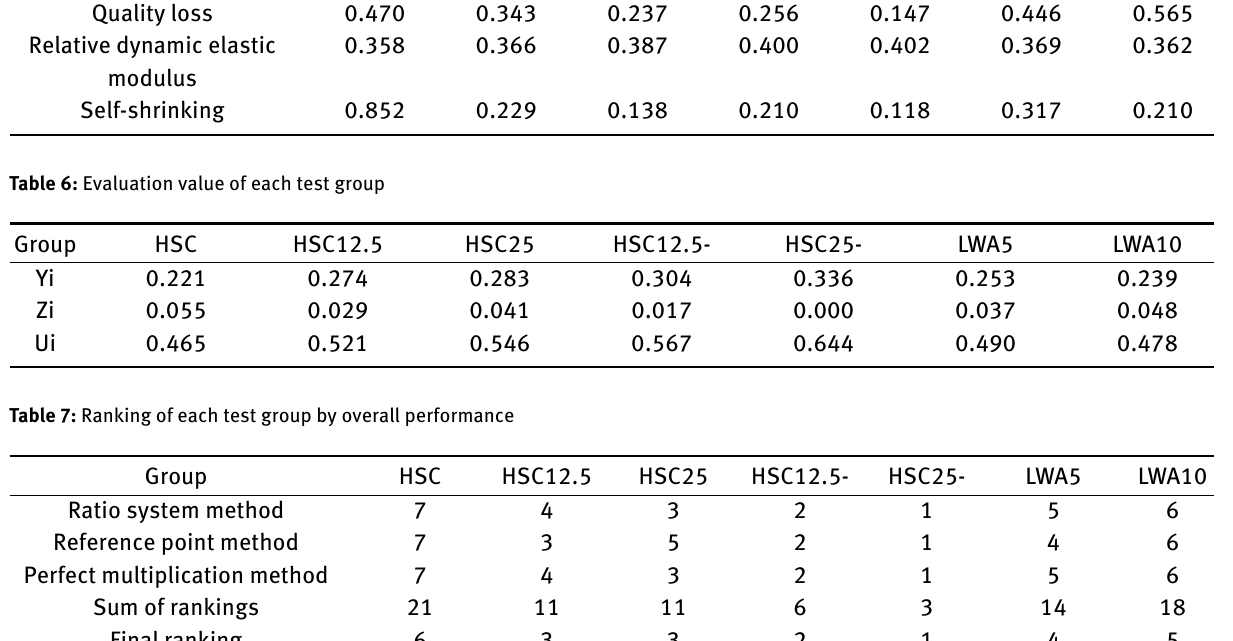
Compressive strength Quality loss